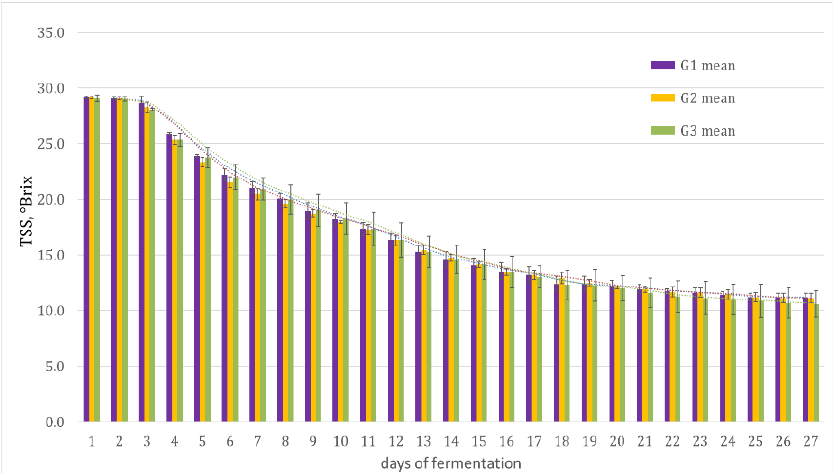
Figure 2. Evolution of the total soluble solids during fermentation of each fig variety (TSS average of 3 repetitions ± standard deviation).